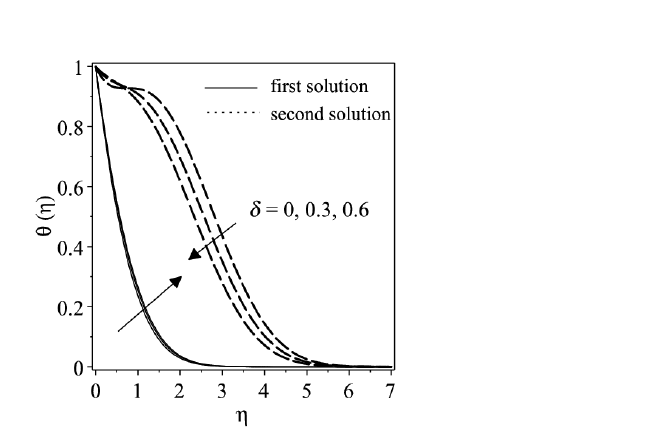
Figure 3. Effect of the slip parameter δ on the velocity profiles f ′ ( η ) when ε = 1, Pr = 1 and λ = − 2 (opposing flow).